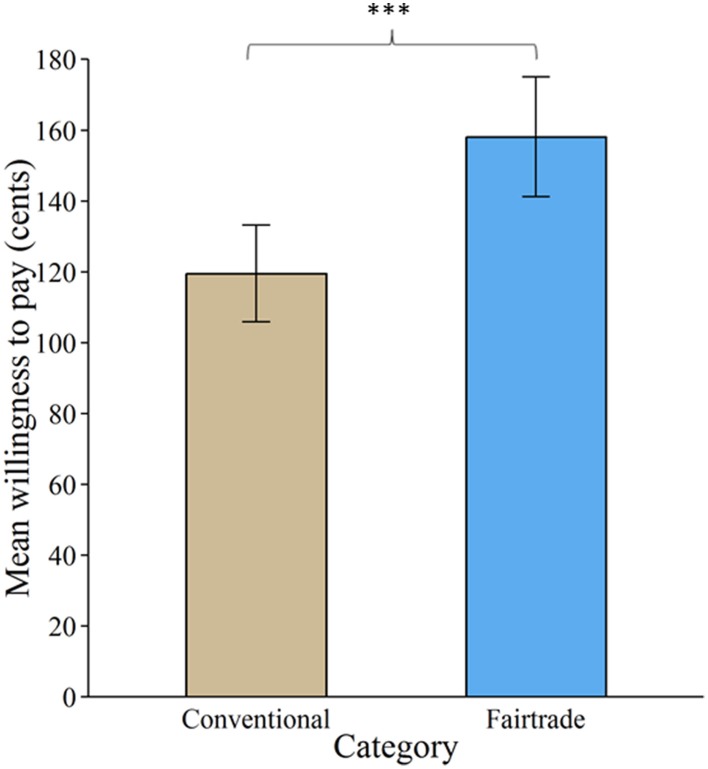
Valuation of products labeled with a Fair Trade emblem vs. no label. Willingness to pay increased significantly for products labeled with a Fair Trade emblem. Error bars indicate standard error of the mean. ***p < 0.001.